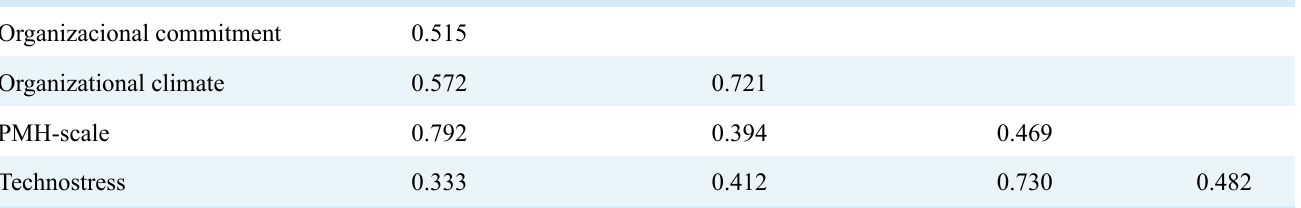
TABLE 4. Heterotrait-monotrait ratio.